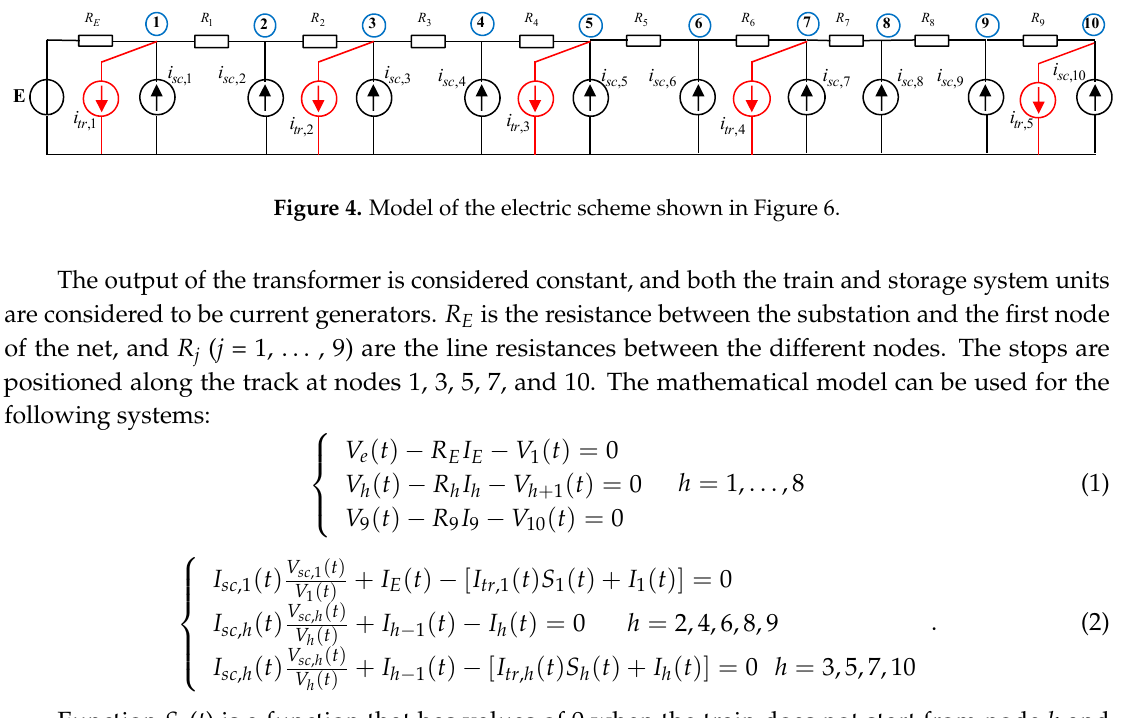
Figure 3. Electric layout of the railway power system for the considered track: integration of photovoltaic modules and of storage systems in the circuit.